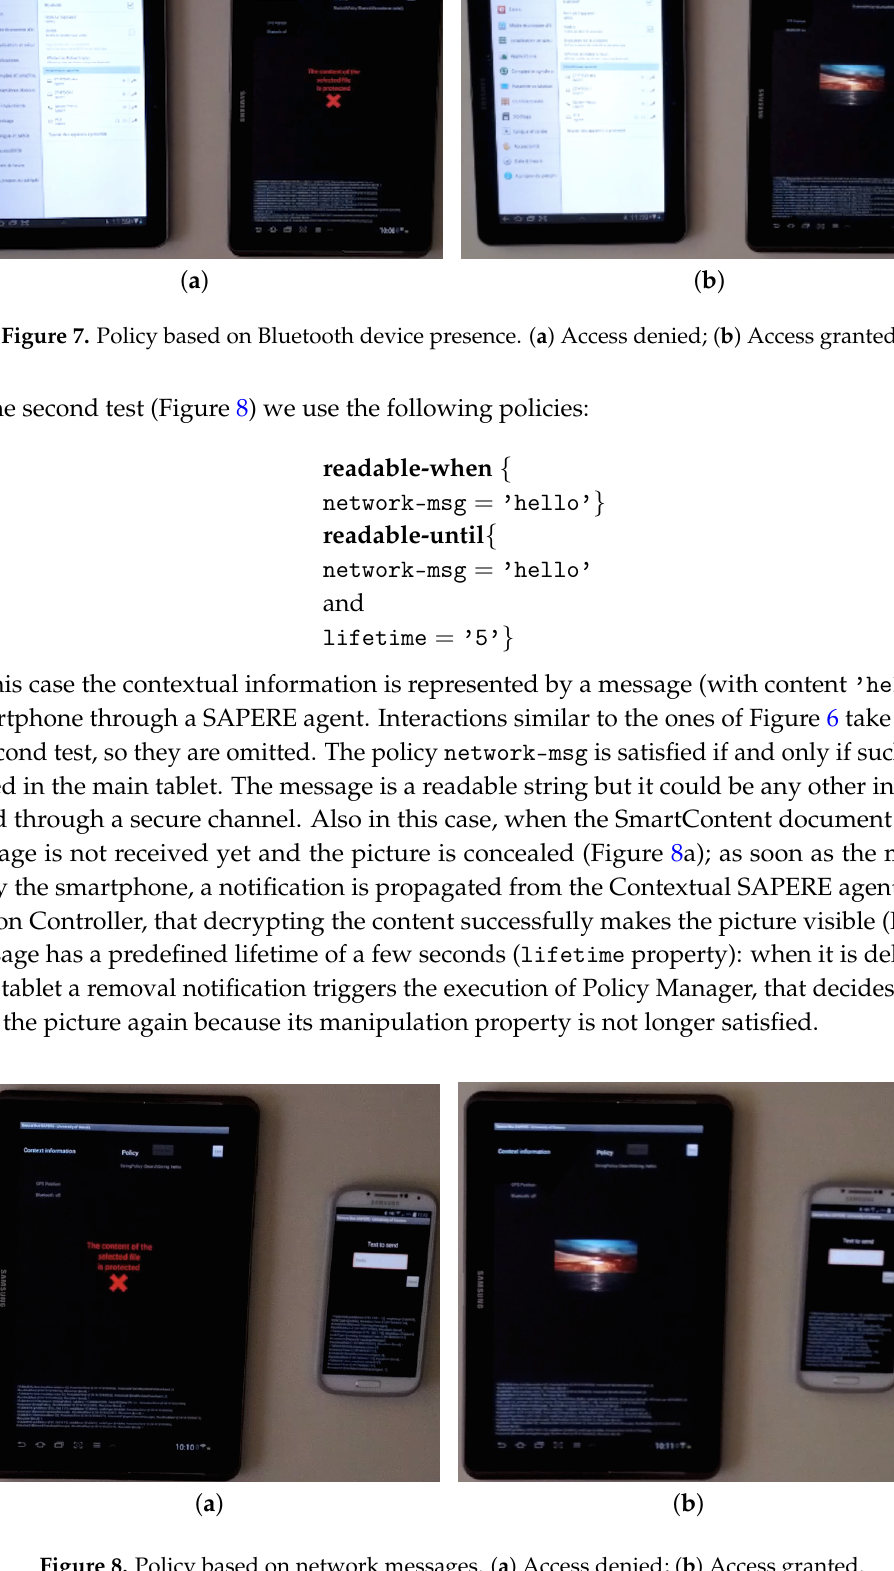
Figure 8. Policy based on network messages. ( a ) Access denied; ( b ) Access